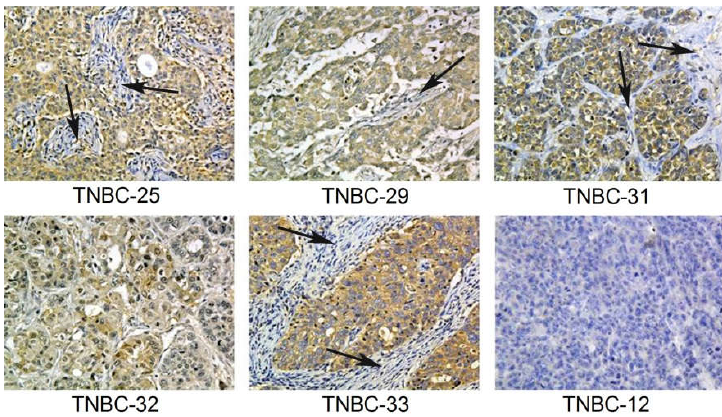
Figure 5. Immunohistochemical Detection of α-Lactalbumin Protein in Human TNBC Tumors. Immunohistochemistry for α-lactalbumin performed on formalin-fixed paraffin embedded human TNBC whole tissue sections showing that 5/6 (83%) tumors showed cytoplasmic immunoreactivity that was diffuse throughout the carcinoma with varying levels of intensity ranging from weak (TNBC-32) to moderate (TNBC-33). Note that the background stromal cells (arrows) are negative. TNBC-12 is negative for protein expression of α -lactalbumin, correlating with the absent gene expression (see Figure 4, lane 7). All sections are shown at 20 ˆ .